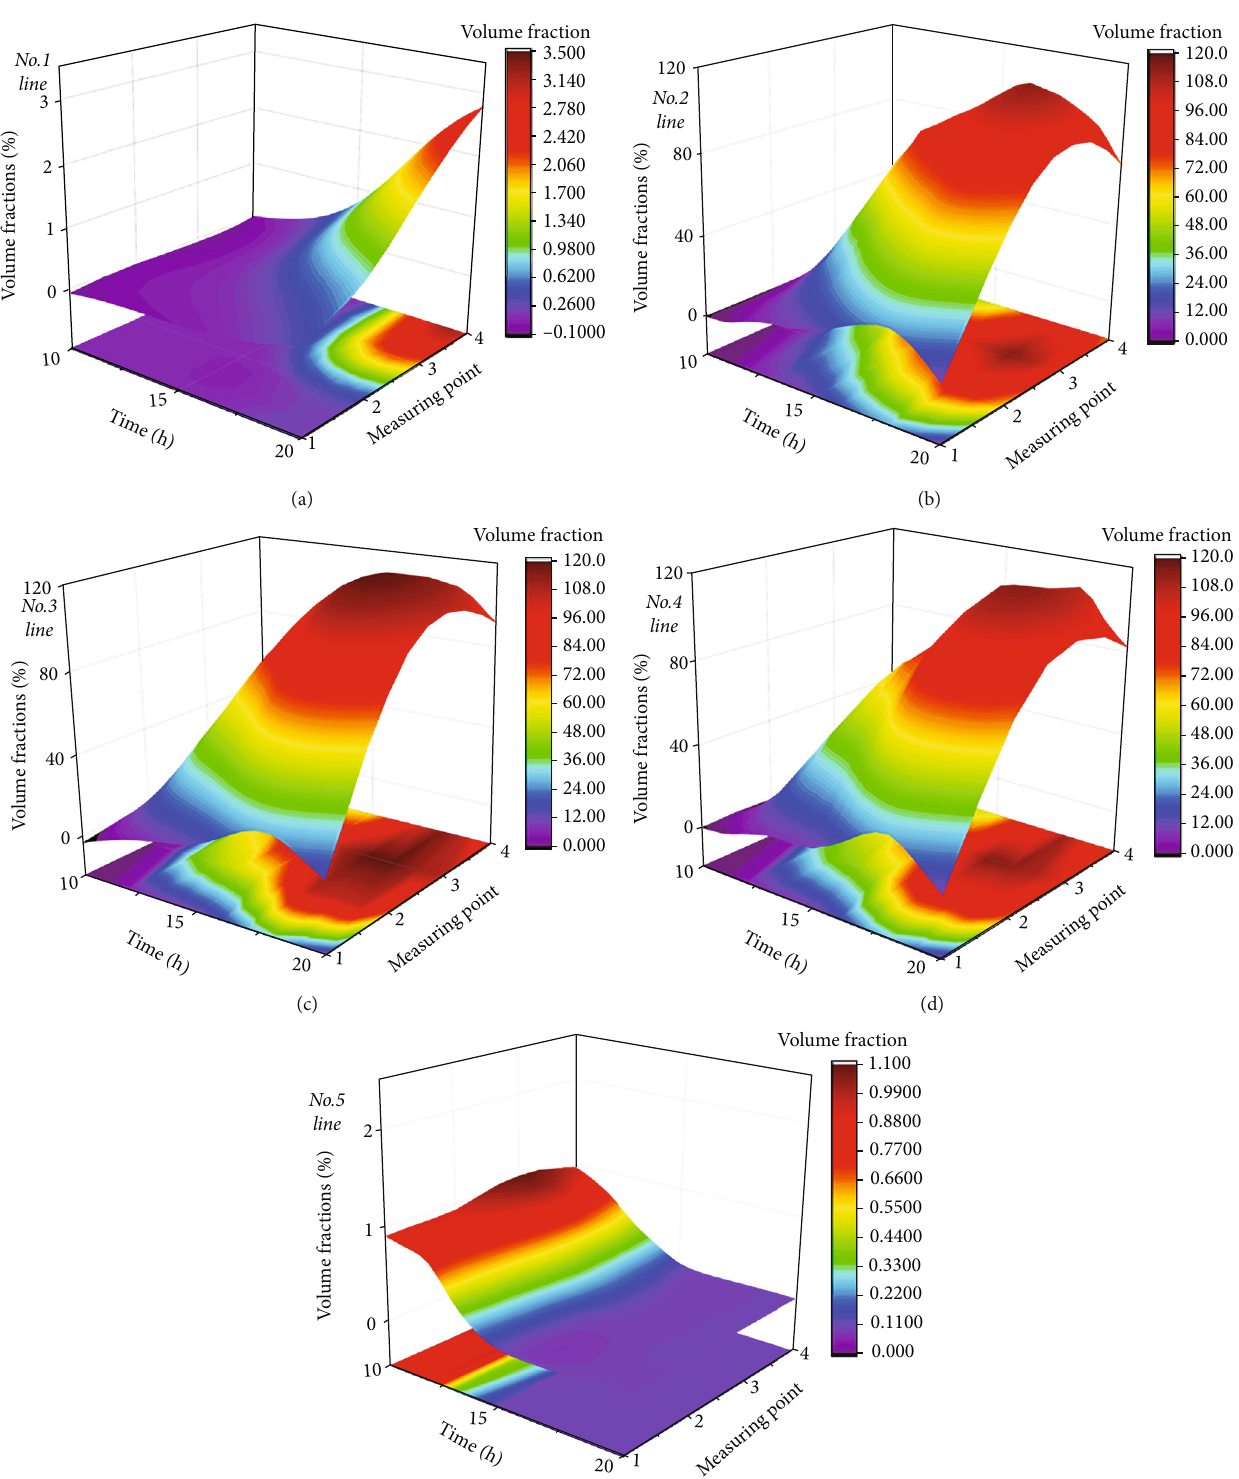
Figure 9: Gradient diagram of SF